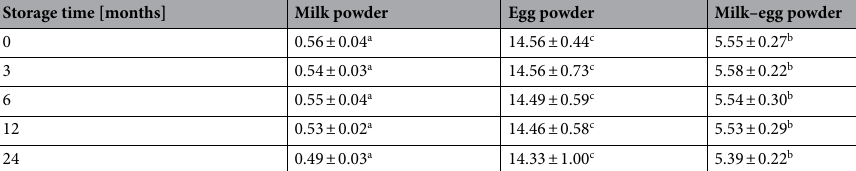
Table 3. Cholesterol content (mg g −1 powder) of powders. a,b —different letters within the column denote statistically significant differences between the results (P < 0.05); ± means